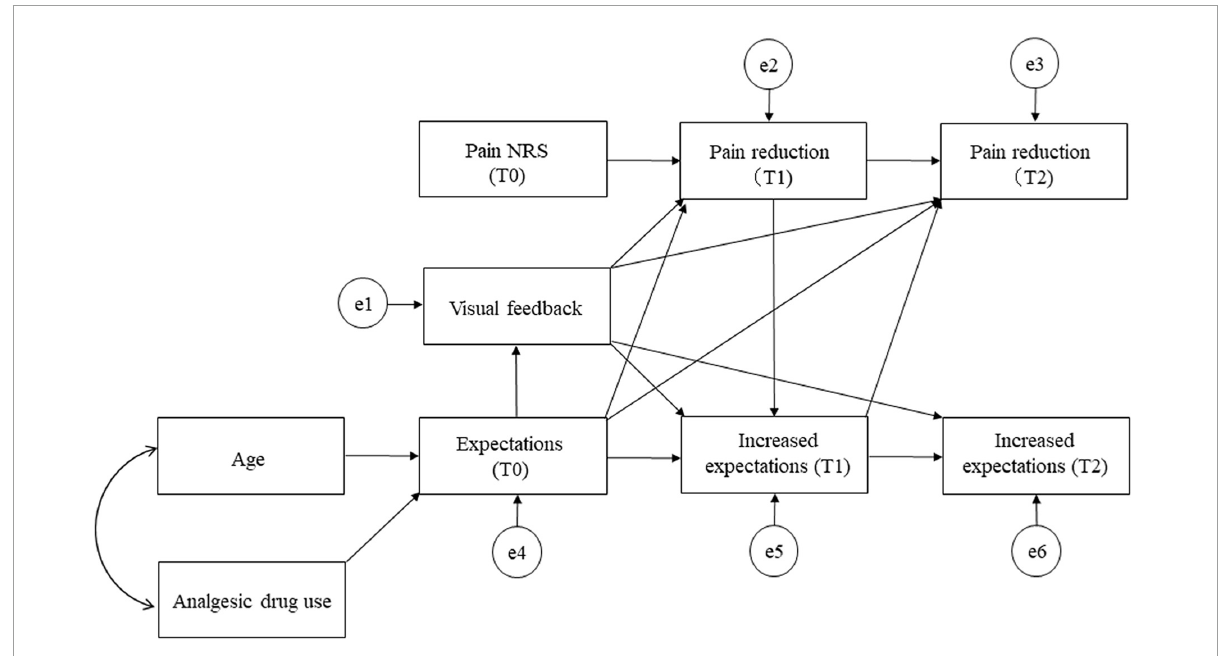
FIGURE3 Between-group comparison of numerical rating scale score change for expectations for treatment and pain.